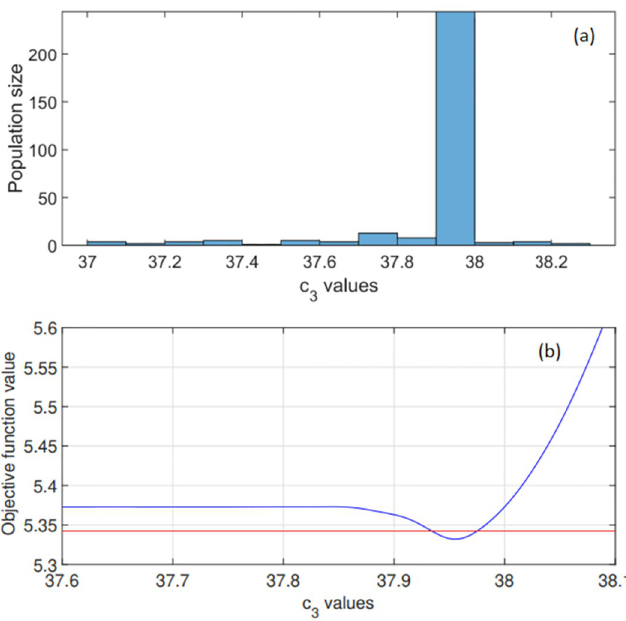
Fig 4. Global optimisation results for parameter c 3 in expression 10 used in 18. (a) The range of potential c 3 values considered is shown along with the optimised c 3 distribution. The genetic algorithm converged to an optimal parameter value on the interval [37.9,38] as c 3 = 37.96. (b) Objective function values: computed profile likelihood for a narrow range of c 3 values. The 95% confidence interval is shown in red as [37.95, 37.98] s.